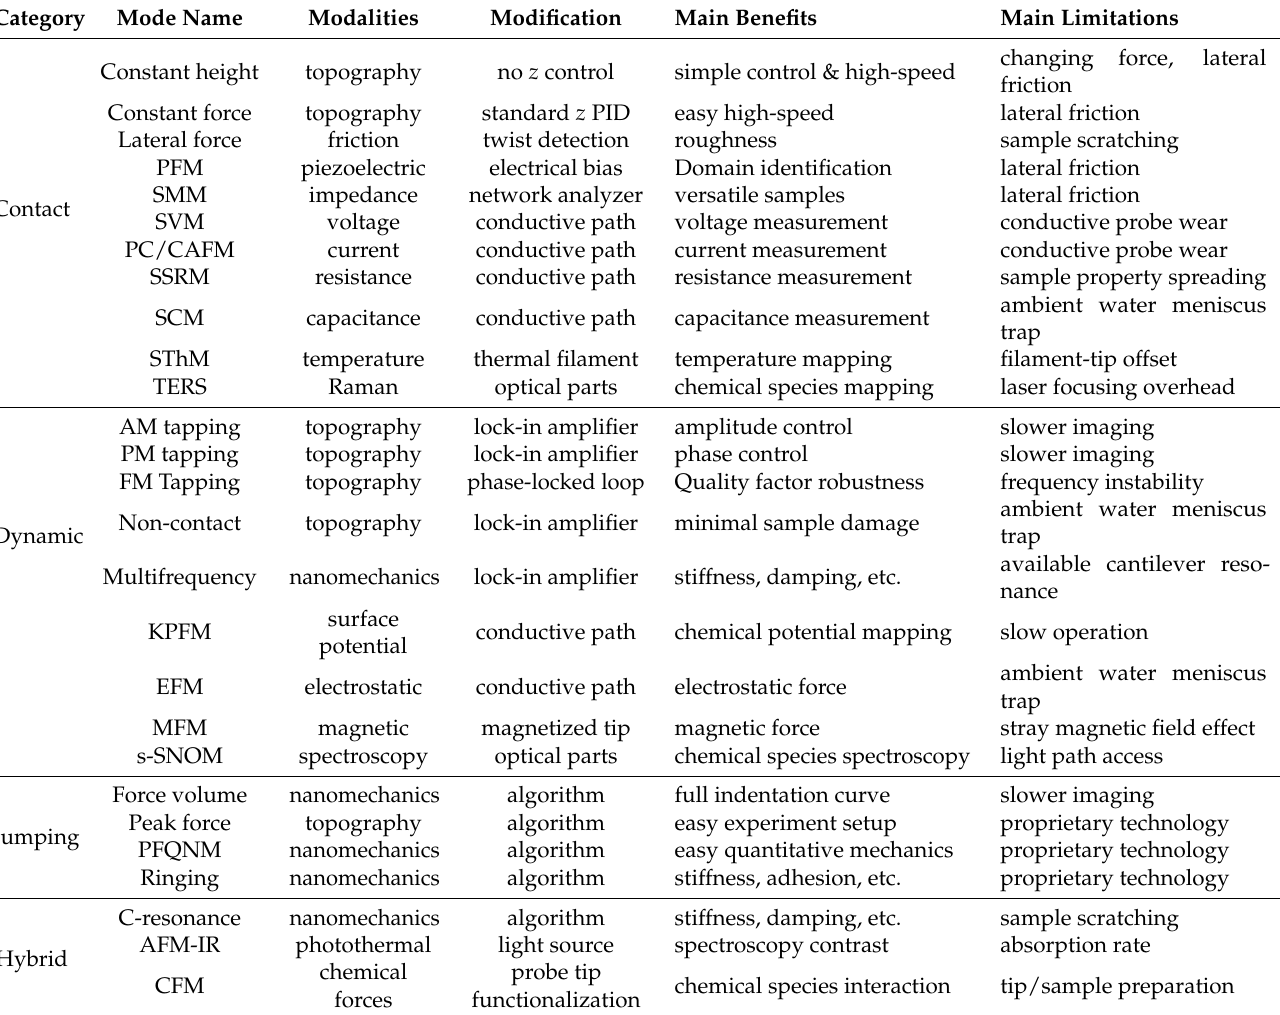
Table 2. AFM Imaging Mode